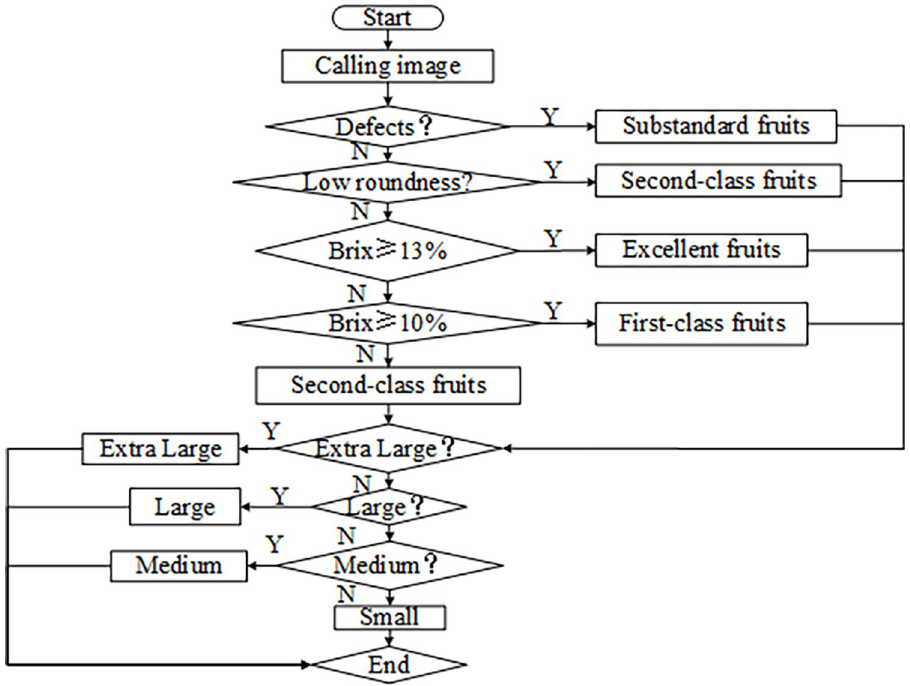
Fig 15. Flow chart of the apple quality grading algorithm.